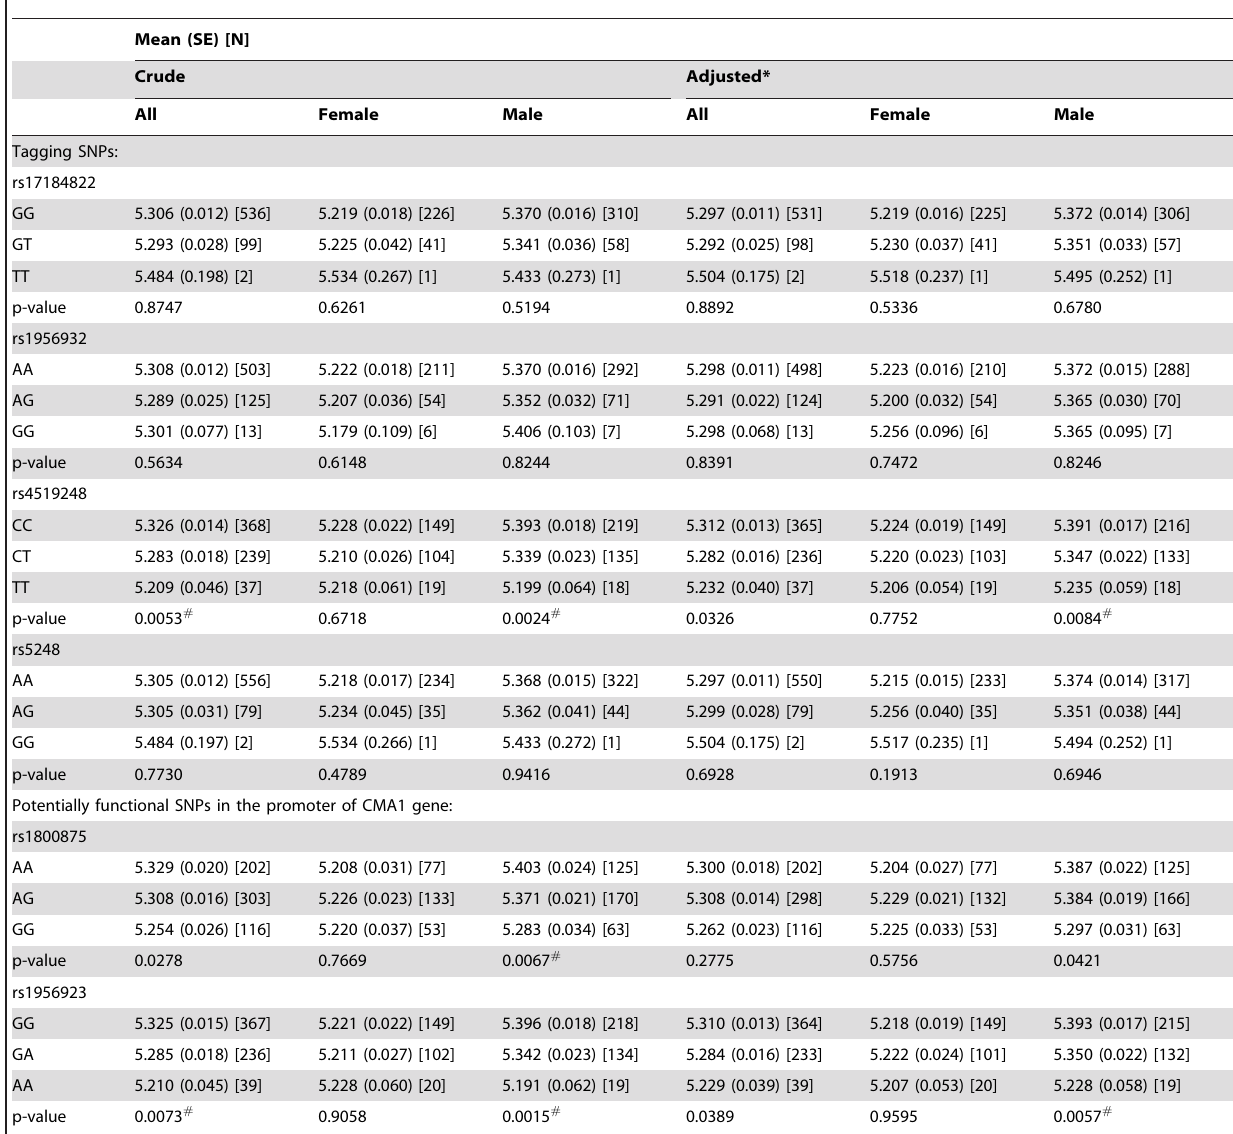
Table 2. Association between tagging and potentially functional SNP in the CMA1 gene and natural logarithm of